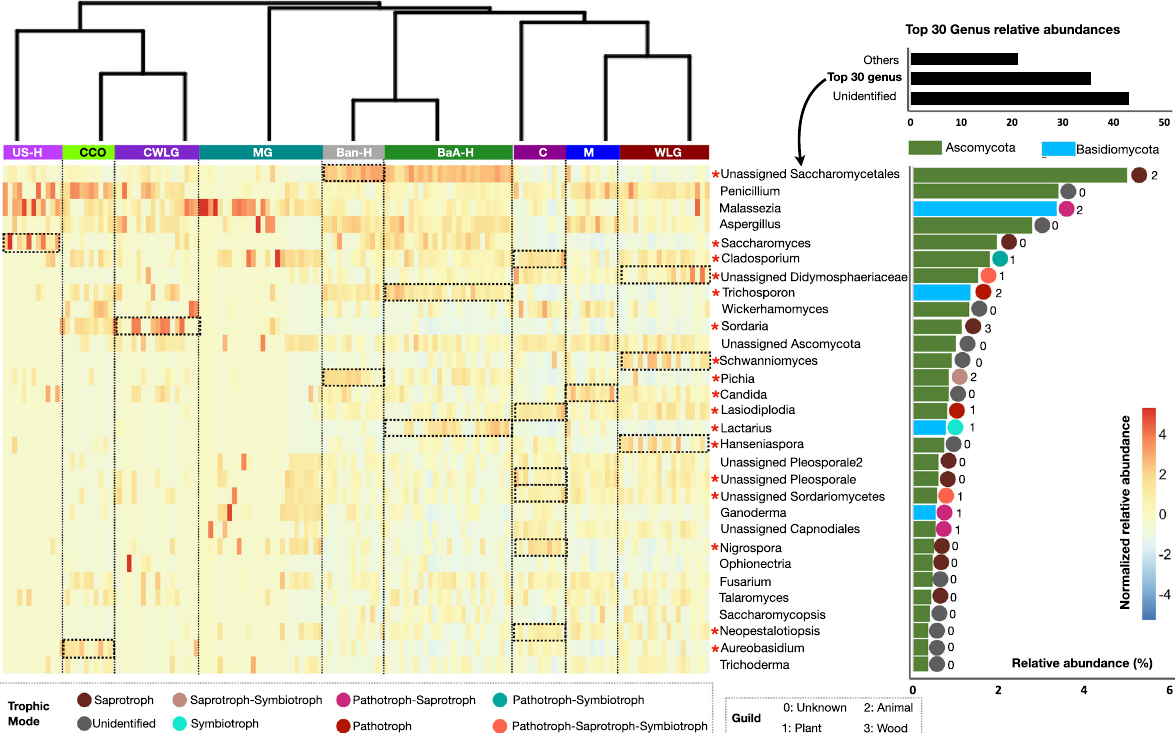
Fig. 2 Heatmap distribution of 30 most abundant fungal genera. Heatmap showing the relative distribution of the 30 most abundant fungal genera based on their normalized relative abundances in each group. Color distribution of individual fungal genera is reported in color key based on normalized Z scores. The primate groups were arranged as per the hierarchical clustering shown in Fig. 1b. Cumulative relative abundance of individual genera across groups is shown in the separate bar plot. Genera highlighted in green and deepskyblue belong to the Ascomycota and Basidiomycota phyla, respectively. Tropic mode and guild of these most abundant genera were selected from the total assigned trophic mode and guild for each ASV. To make FUNGuild assignments more accurate, only ASVs ranked as “ Probable ” and “ Highly Probable ” hits were considered for fi nal classi fi cation. ASVs ranked as “ Possible ” were not considered. These categories are shown at the bottom of the heatmap with different colors and numbers. The dotted boxes along with the asterisk are drawn to show statistical signi fi cance (based on species indicator analysis, indval > 0.3, and p < 0.05) of each fungal genera in the respective primate group. The identi fi ers used for primate groups are US-H: US-Human, CCO: Captive Chimpanzees Ostrava, CWLG: Captive Western Lowland Gorilla, MG: Mountain Gorilla, mycobiome-bacteriome interactions (Fig. 4a and Supplementary Fig. 9a), with all nonhuman primates showing denser networks (higher number of bacteria-fungi associations) but lower mod- ularity (dense connections between nodes across different modules) relative to all humans. However, the gut microbiome of US humans always showed the fewest number of associations between bacteria and fungi; for example, only one fungal taxon was found associated with a few bacterial species (r > 0.6, q < 0.01),